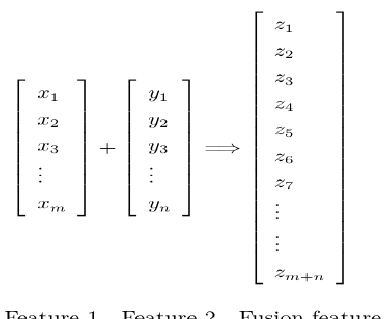
Figure 9. Feature fusion process based on concat.